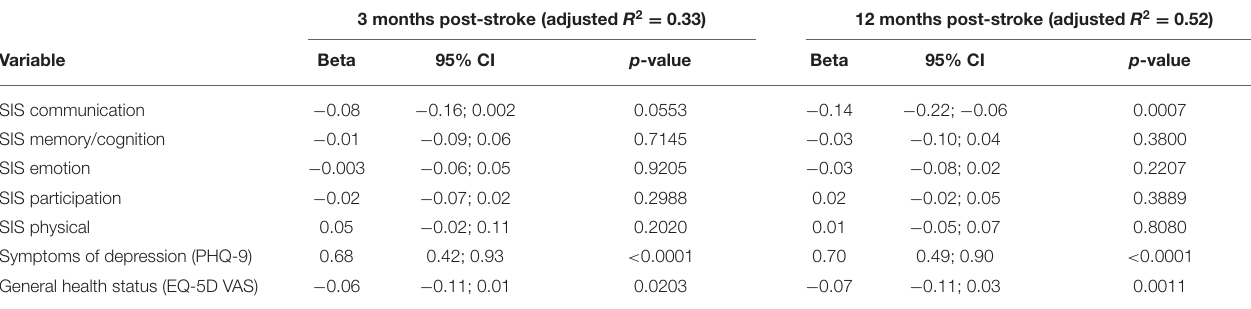
TABLE 6 | Multivariable linear regression model of fatigue (Fatigue Impact Scale score) at 3 and 12 months post-stroke ( n = 448). 3 months post-stroke (adjusted R 2 =